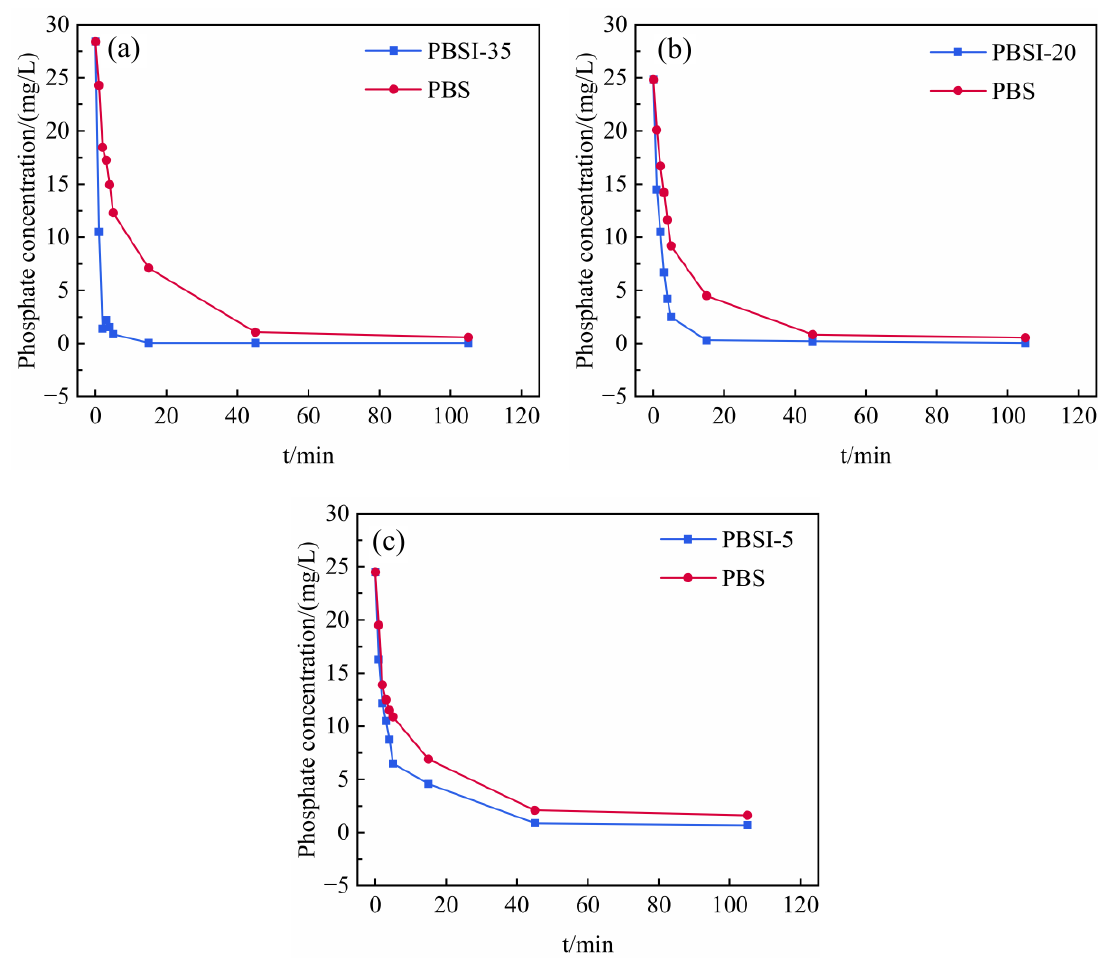
Figure 4. Changes in the phosphate concentration in backfill slurry with different amounts of ITs: ( a ) 35% ITs addition; ( b ) 20% ITs addition; and ( c ) 5% ITs addition.